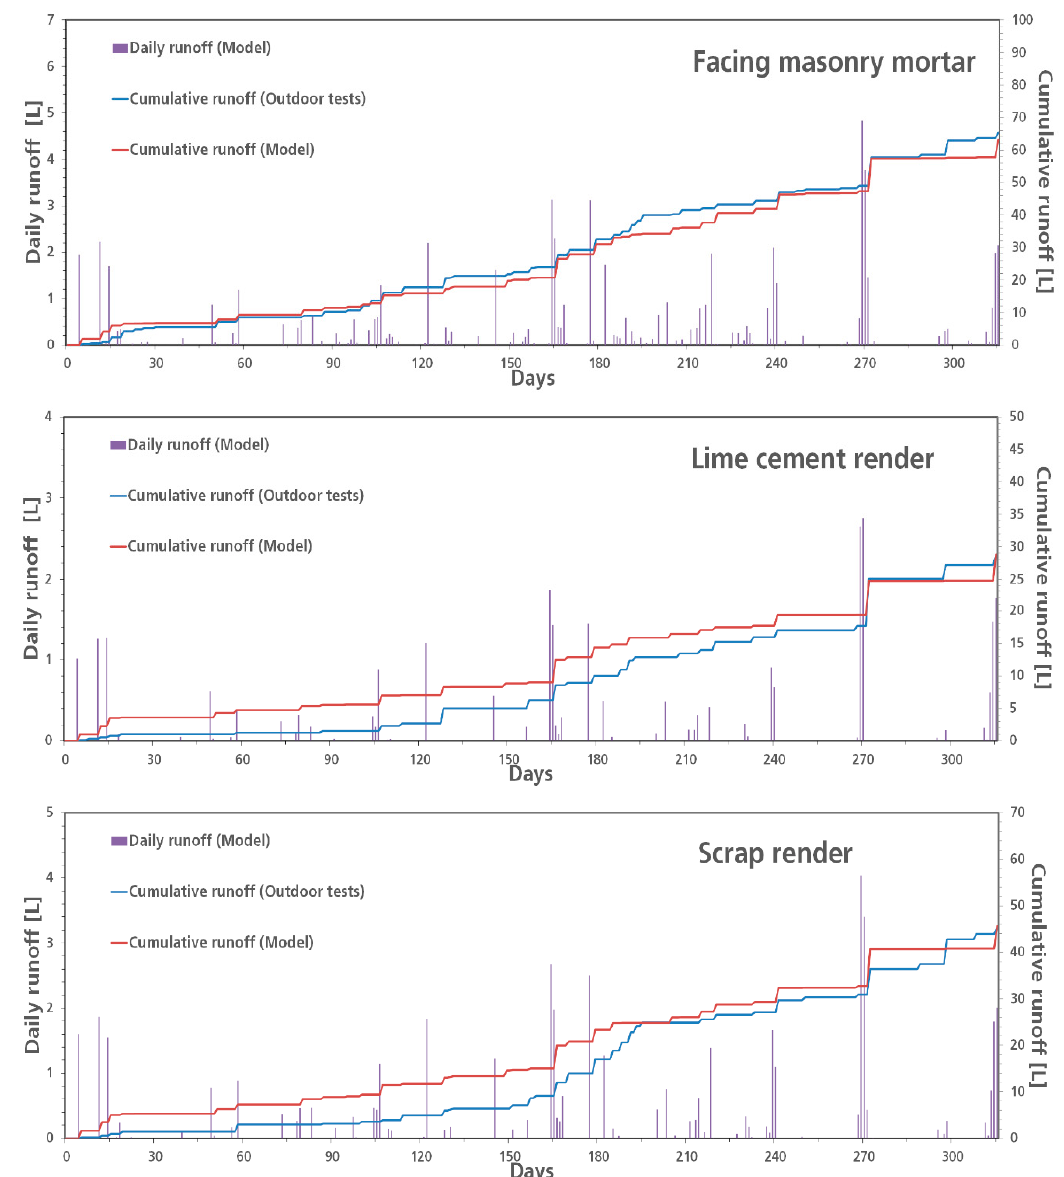
Figure 5. VTP daily-simulated runoff and cumulative simulated/actual runoff for facing masonry mortar ( up ), lime cement render ( middle ) and scrap renders ( down ).